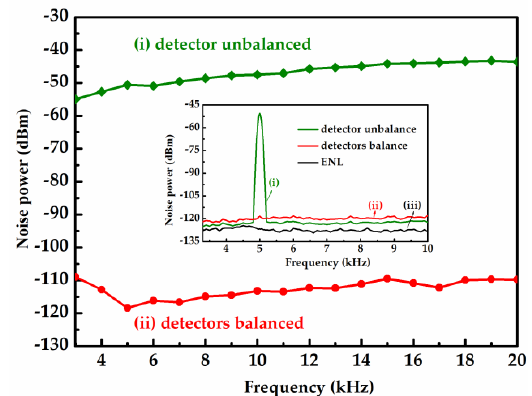
Figure 5. Measured noise power from unbalanced detector and balanced detectors as a function of analysis frequencies: Curve (i), detector unbalanced; and Curve (ii), detectors balanced. The CMRR of photodetectors in the BHD system was determined by the difference of noise power from balanced detectors and that from unbalanced detector. The inset is the measurement for the CMRR of photodetectors at the analysis frequency of 5 kHz.